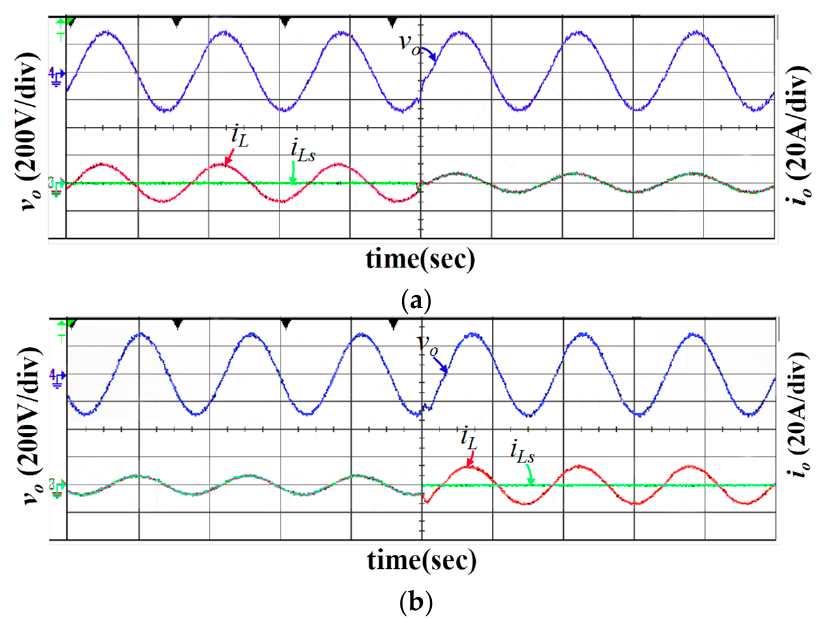
Figure 14. Experimental results under slave inverter connection and disconnection by the proposed AFSMC: ( a ) slave inverter connection; ( b ) slave inverter disconnection.